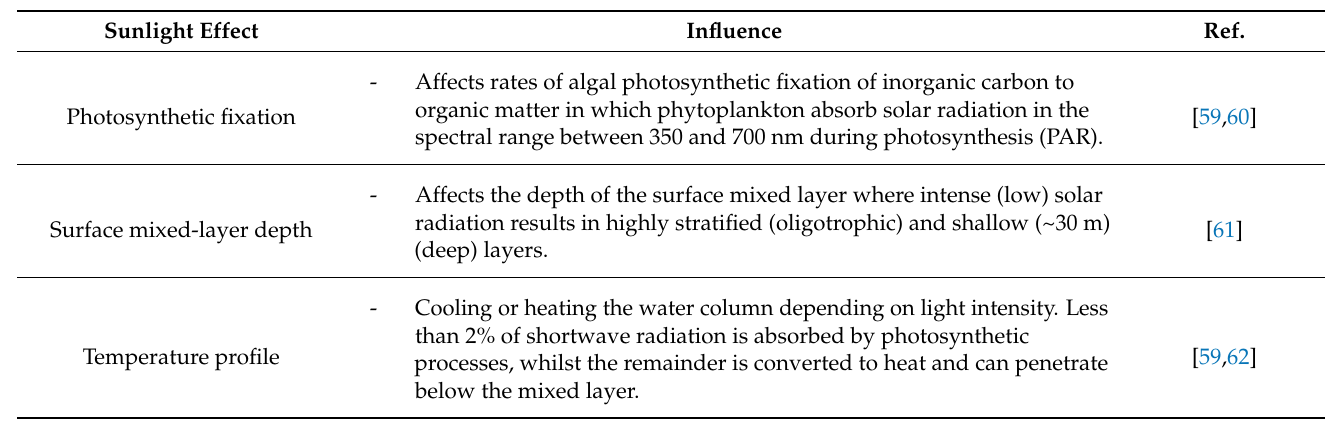
Table 3. The effect of sunlight on NIO